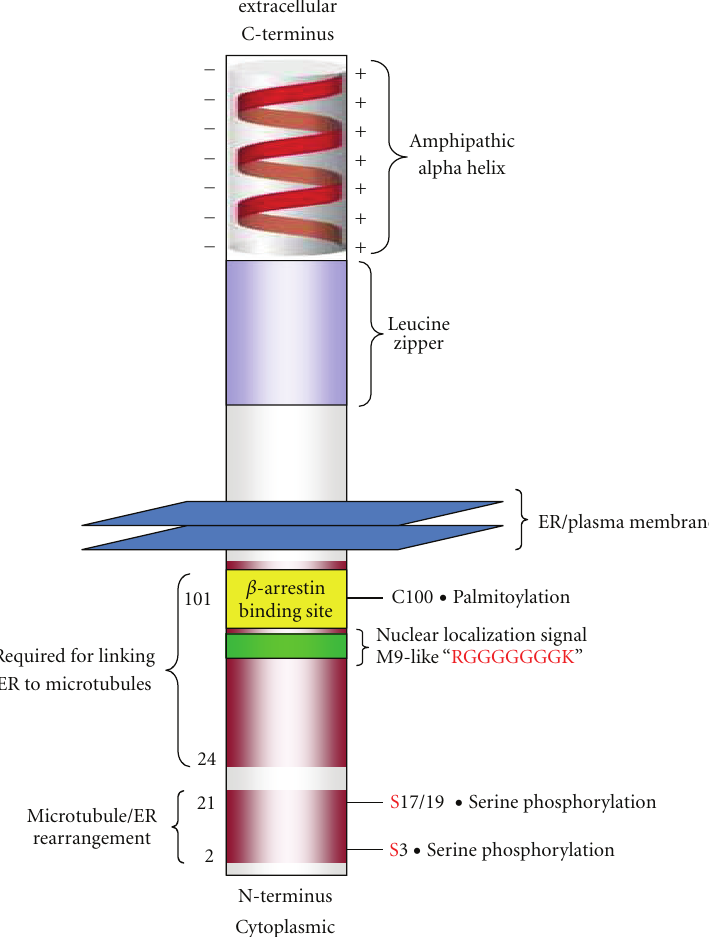
Figure 1: CKAP4 domains . CKAP4 is a 63kDa, oligomeric, type II, single-pass TM domain protein that is palmitoylated and phos- phorylated. The luminal/extracellular domain contains an amphipathic alpha helical region (506-KVQEQVHTLLSQDQAQAARLPPQD FLDRLSSLDNLKASVSQVEADLKMLRTAVDSLVAYSVKIETNENNLESAKGLLDDLRNDLDRLFVKVEKIHEKV-602) that is important for oligomerization and a leucine zipper (468- L ASTVRS L GETQLV L YGDVEE L KRSVGE L PSTVES L -504). Together, these regions are homolo- gous to the DNA-binding domain of bZIP transcription factors. The cytoplasmic, N-terminus contains a cysteine residue adjacent to the TM domain at position 100 that is palmitoylated (a modification that is important for tra ffi cking from the ER to the PM), and three serine residues (S3, S17, and S19) that are required for phosphorylation-dependent binding of CKAP4 to the microtubule cytoskeleton. Two regions in the cytoplasmic N-terminus are required for binding to and bundling microtubules, thereby maintaining the connection between the ER and the cytoskeleton [3]. There is also a PQ protein-protein interaction domain (49-PHPQQHPQQHPQNQ-63) and a putative glycine-rich nuclear localization signal sequence